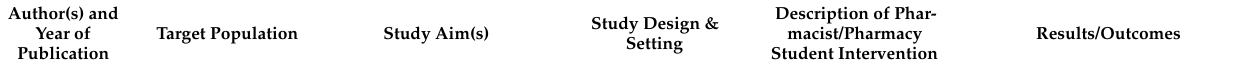
Table 7. Secondary Care interventions for long-term management post the acute phase of